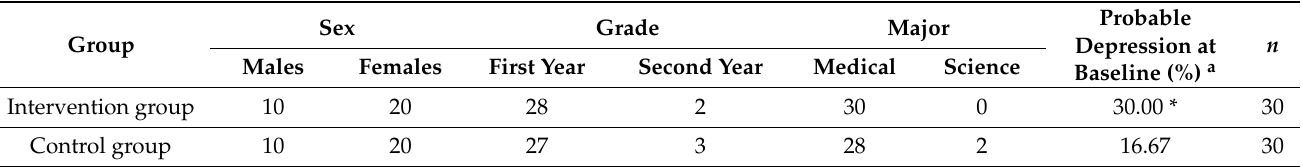
Table 5. The demographic characteristics and probable depression of participants at